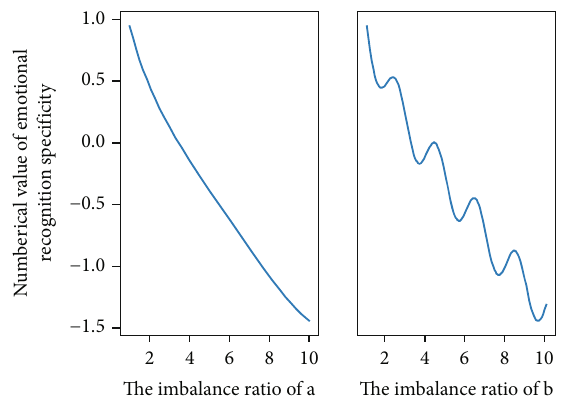
Figure 2: Disproportionately speci fi c classi fi cation of emotion recognition.